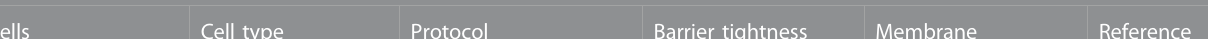
TABLE 2Overview of aselection of protocolsfor the generation ofblood-brainbarriersusinginduced pluripotent stem cells withor without the presence ofother cells. Selected protocols for the generation of blood-brain